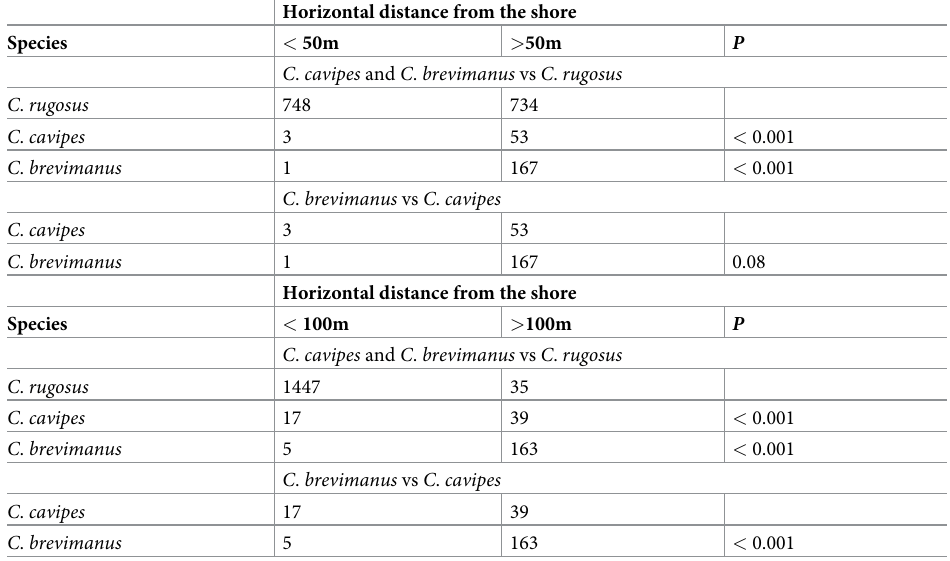
Table 2. Differences in horizontal distance from the shore for three terrestrial hermit crab species (basis: 50 and 100 meters). P = probability ( χ 2